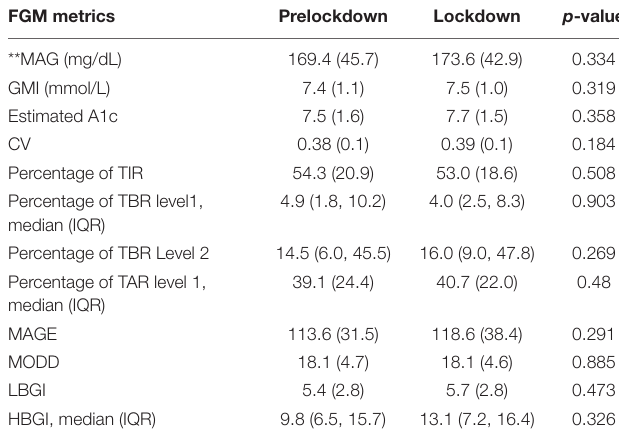
TABLE 1 | Comparison of FGM metrics between *prelockdown and lockdown